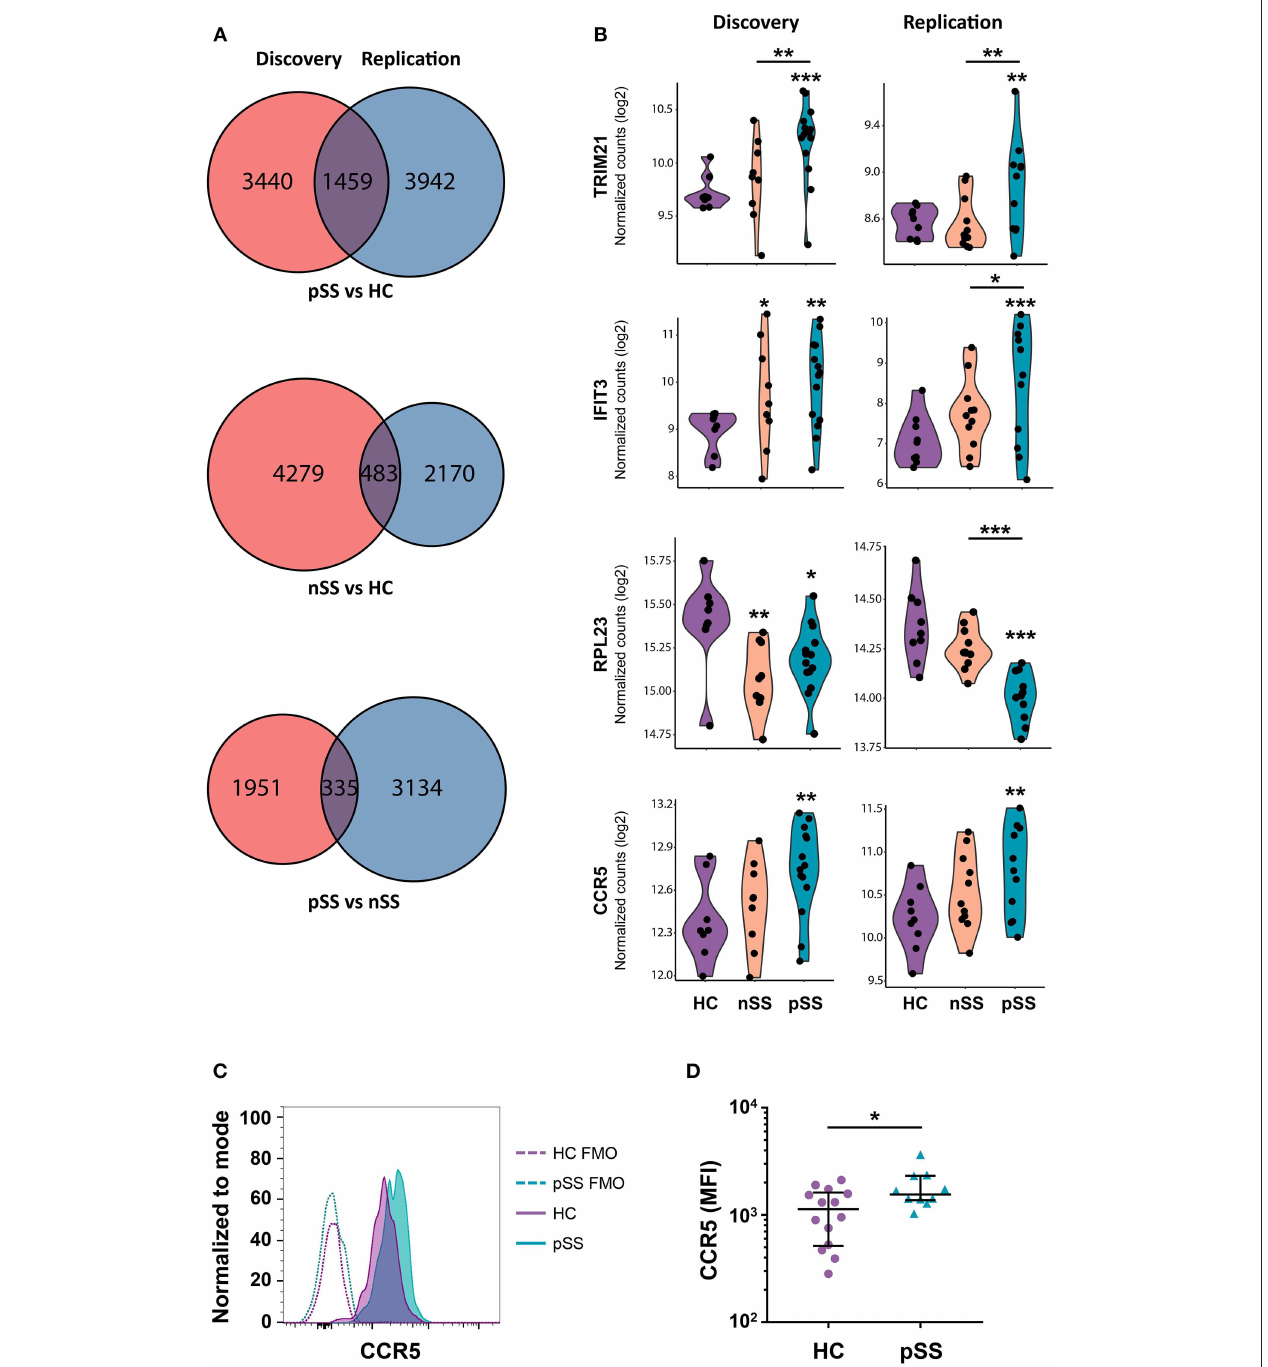
FIGURE 2 | A large set of genes is consistently differentially expressed in patients and CCR5 is increased on the surface of pSS pDCs. Venn diagrams showing the genes differentially expressed (nominal p -value < 0.05) in the discovery and replication cohort for the three group comparisons (A) . Violin plots of a selection of differentially expressed genes are depicted; expression is shown in normalized read counts, which is plotted on a 2log axis. (B) . Mononuclear cells were isolated from peripheral blood of HC and pSS donors and the expression of CCR5 on the surface of lineage-negative and HLA-DR + CD123 + BDCA-2 + pDCs from pSS patients ( n = 10) and HC ( n = 14) was assessed using flow-cytometry. A representative histogram from one HC and pSS donor is depicted in (C) , fluorescence minus one (FMO) controls are indicated with a dotted line. Median fluorescence intensity (MFI) is plotted (D) . *, **, and *** represent p < 0.05, p < 0.01, and p < 0.001, respectively.